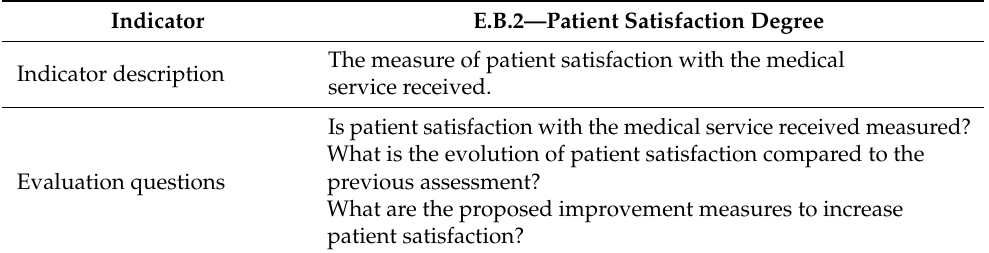
Table 15. E.B.2—Patient satisfaction degree.